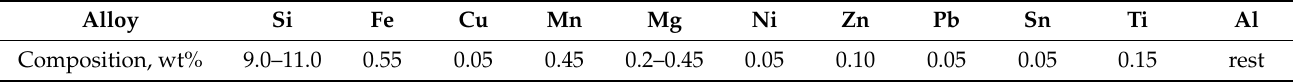
Table 2. Tin-based alloy composition, wt%.